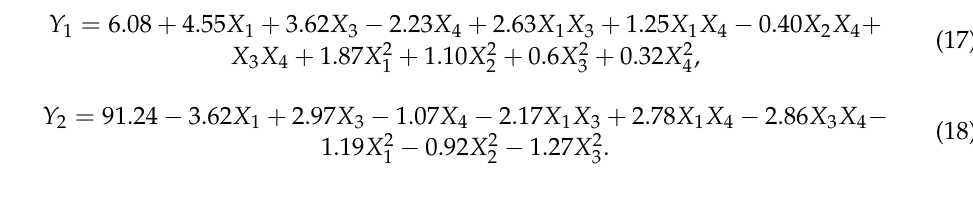
Table 4. ANOVA of test results.